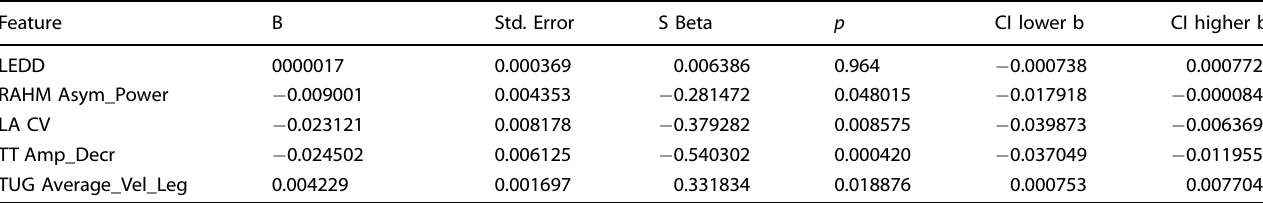
Table 4. Multiple linear regression model to predict the motor outcome at T3, measured as the % variation in UPDRS III score between baseline and T3 (dependent variable).